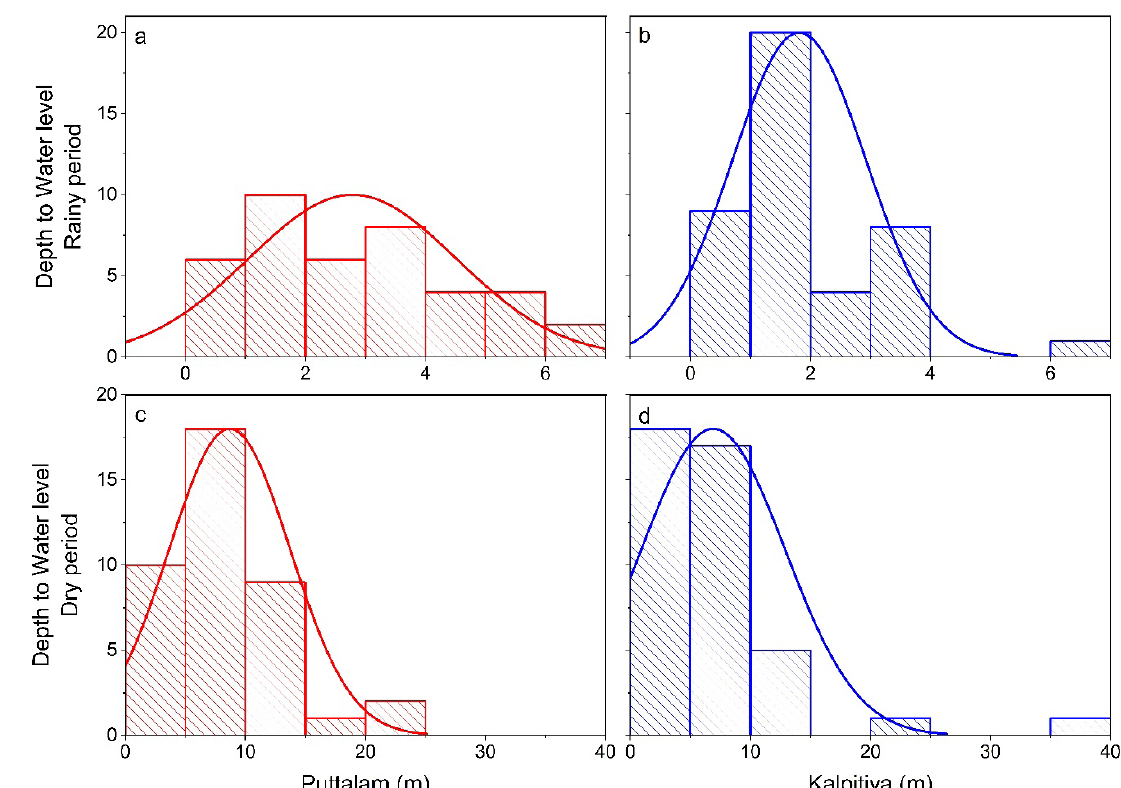
Figure 4: Histograms showing the respective depth to water level counts recorded at Puttalam and Kalpitiya wells during the dry and the rainy periods. Table 4: Mann-Whitney U test results for water levels in dry and rainy periods between Puttalam and